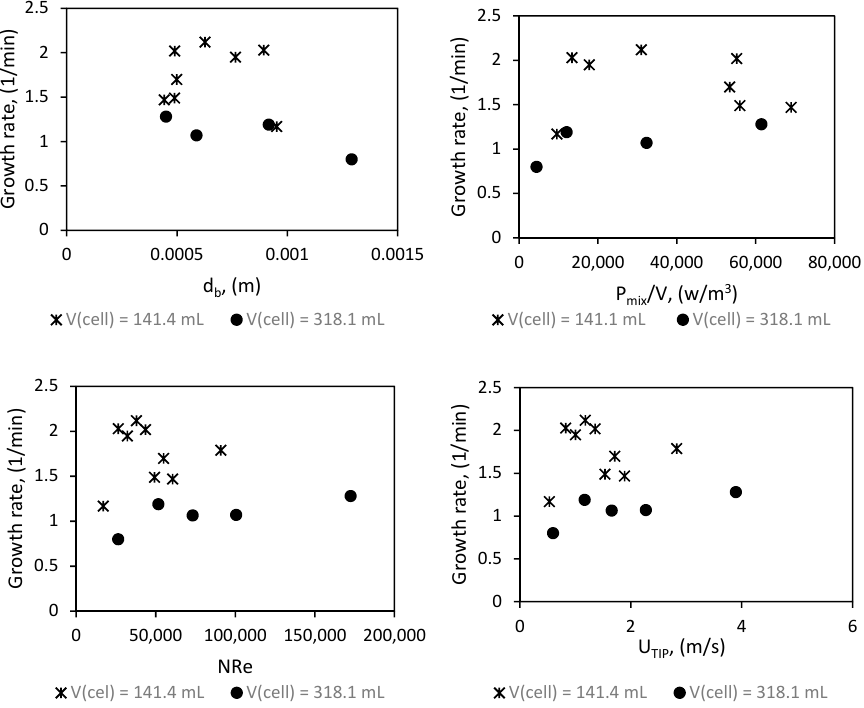
Figure 18. Hydrate growth rate as a function of d b , N Re , U TIP , and P/V in the 141.4 mL and 318.1 mL cells (6 °C). The gas-water volume ratio, V G /V L , was 1.828 (cf. Table 1) in all experiments.